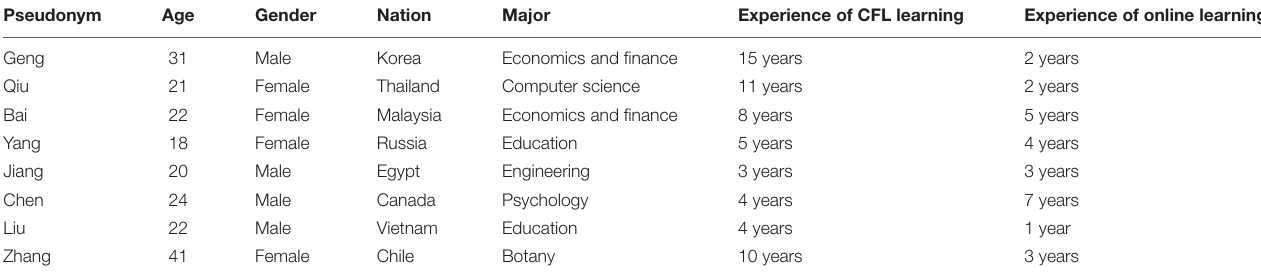
TABLE 2 | The demographic information of the interviewees ( n =